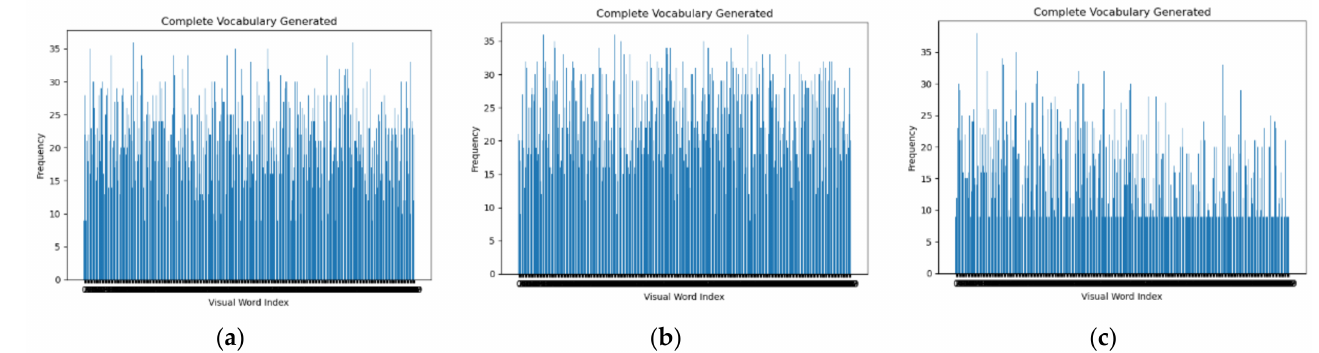
Figure 6. ( a ) Feature extraction histogram of SIFT; ( b ) Feature extraction histogram of Hog; ( c ) Feature extraction histogram of Canny.